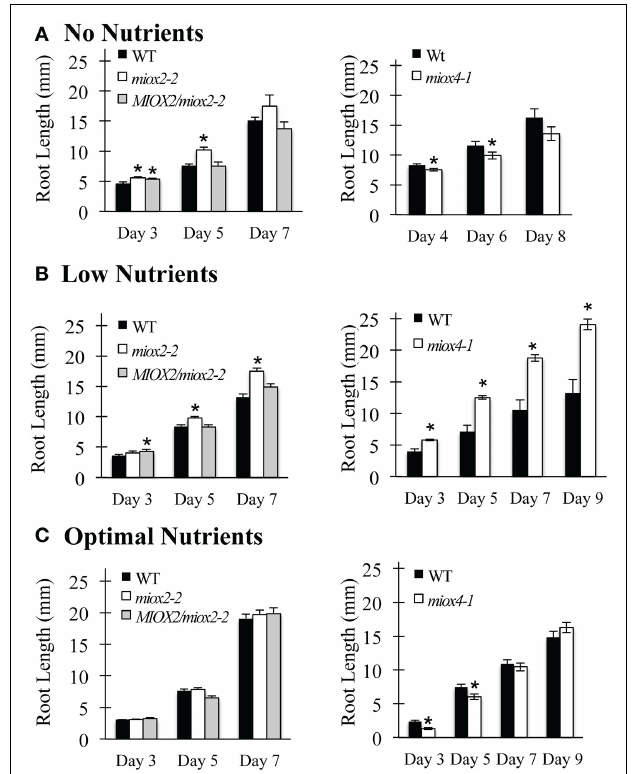
FIGURE 2 | Characterization of MIOX2 and MIOX4T-DNA Insertion Mutants. (A) . MIOX2 (A) and MIOX4 (B) gene maps showing locations of T-DNA insertions. Black boxes represent exons, black lines represent introns. LB:T-DNA left border, RB:T-DNA right border. Arrows indicate primers. (C) Relative transcript levels of MIOX2 (left) and MIOX4 (right) in WT, miox2-2 and miox4-1 mutant seedlings as determined by quantitative